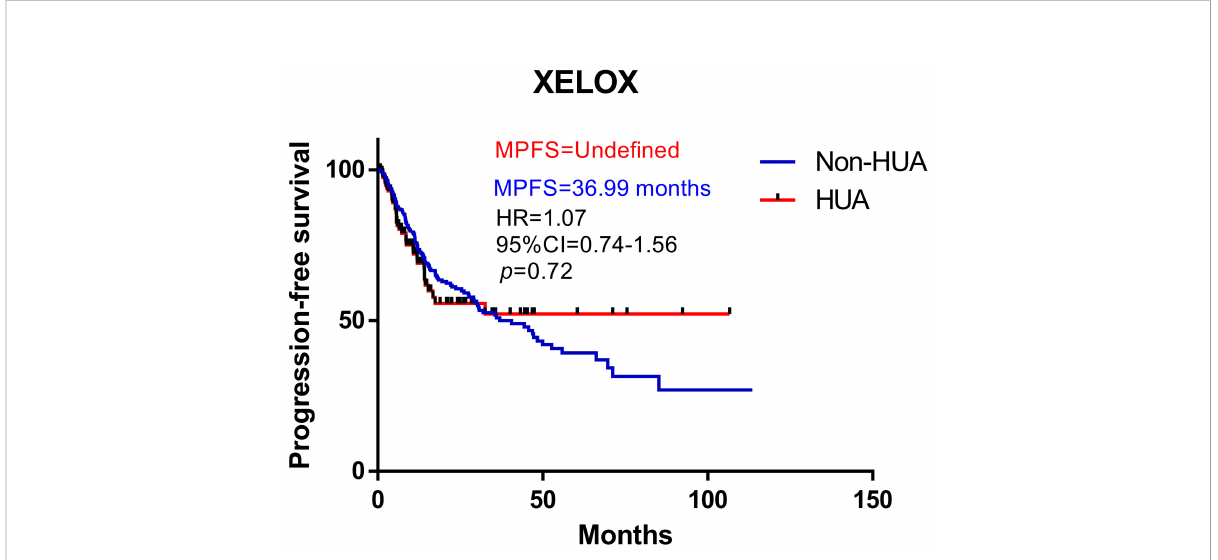
FIGURE 5 Kaplan-Meier plots comparing the PFS of the different baseline SUA level CRC patients treated with XELOX. HUA, high uric acid, Non-HUA, nonhigh uric acid, MPFS, median